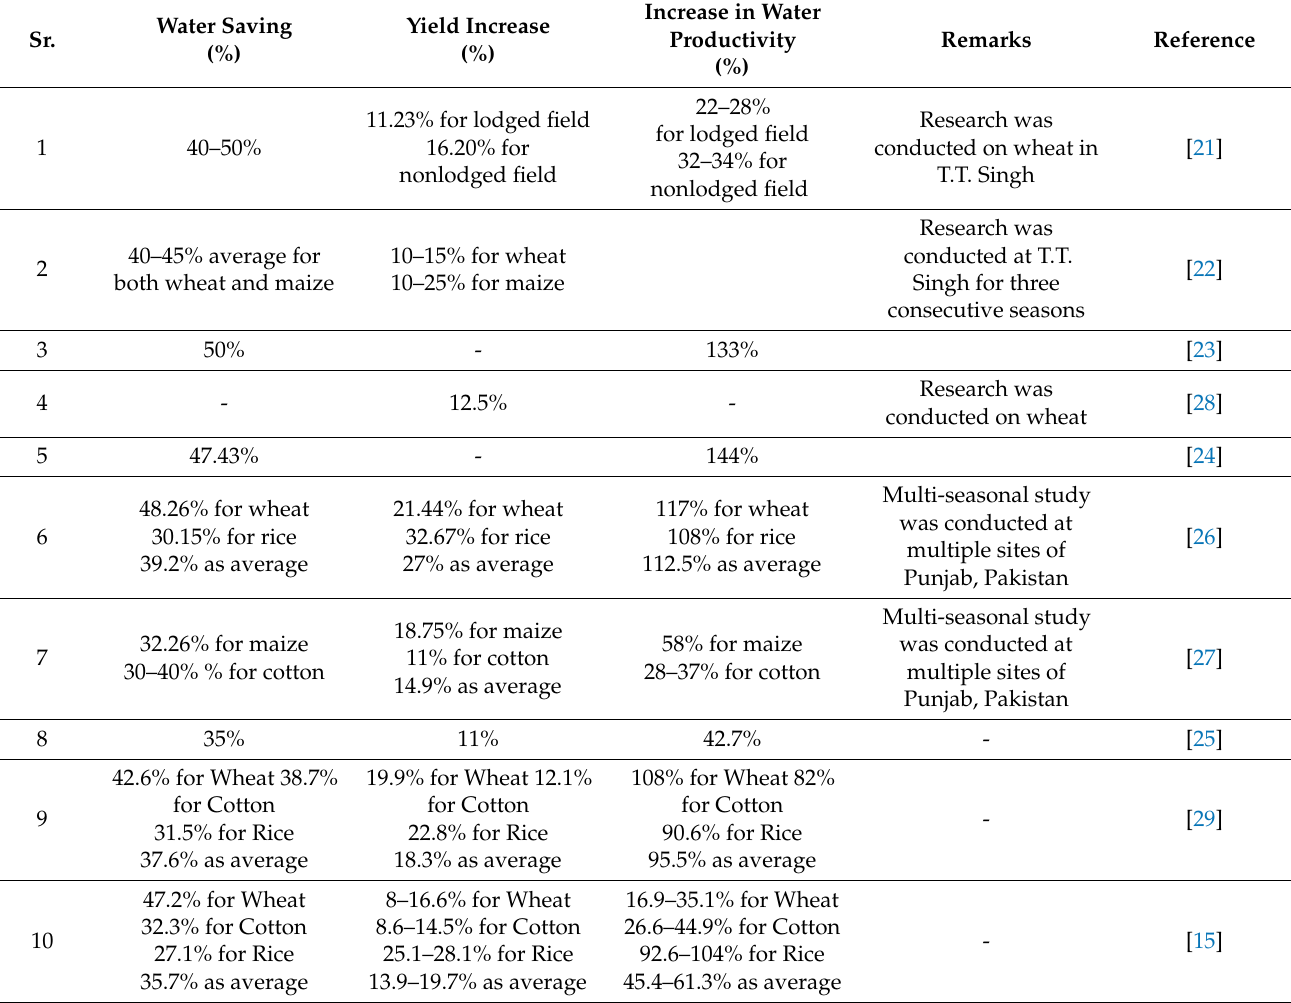
Water saving, yield increase, and water productivity improvement under Raised Bed